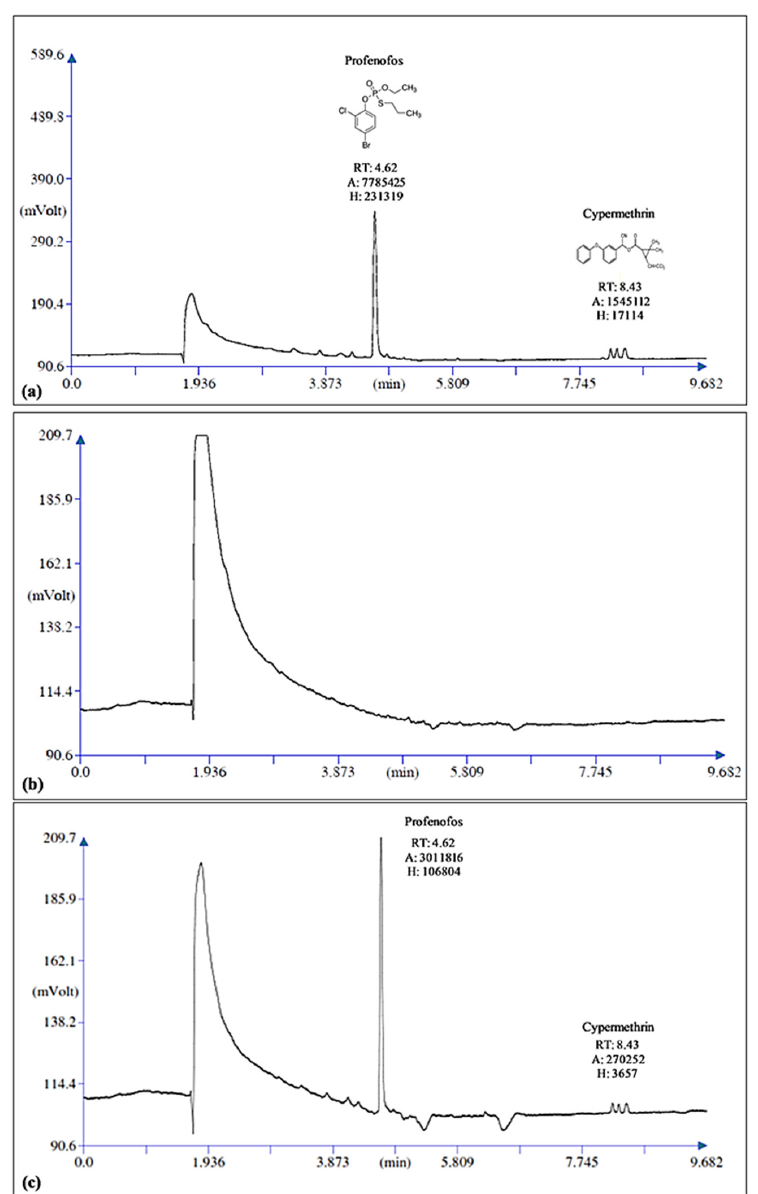
Figure 3. Figure 3.Figure 3. Figure 3. GC-chromatogram of profenofos and cypemethrin on GC-ECD (a) at standard 0.05 mg/kg (b) in control and (c) in sapota fruit sample at standard dose